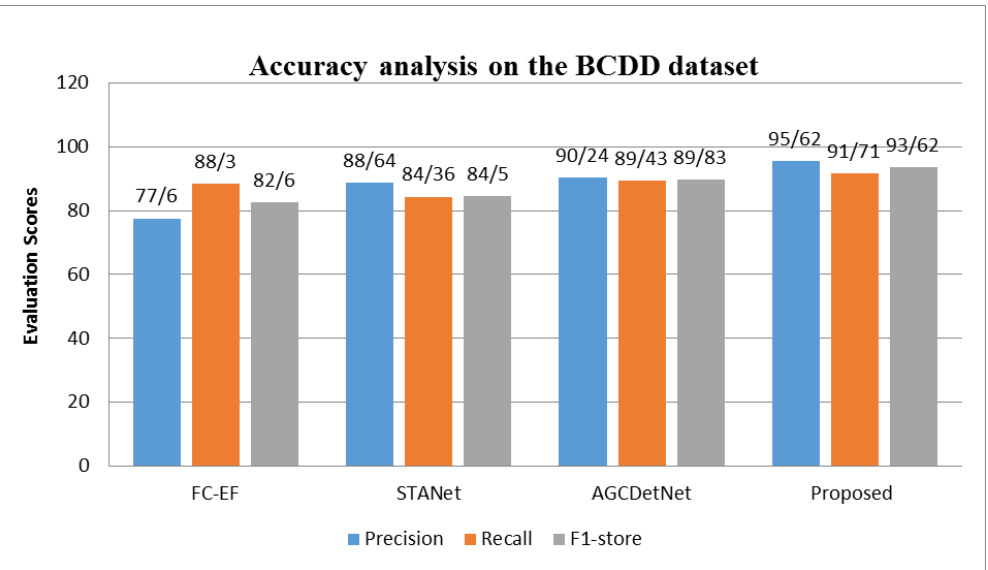
Figure 5. Accuracy comparison between state-of-the-art and proposed